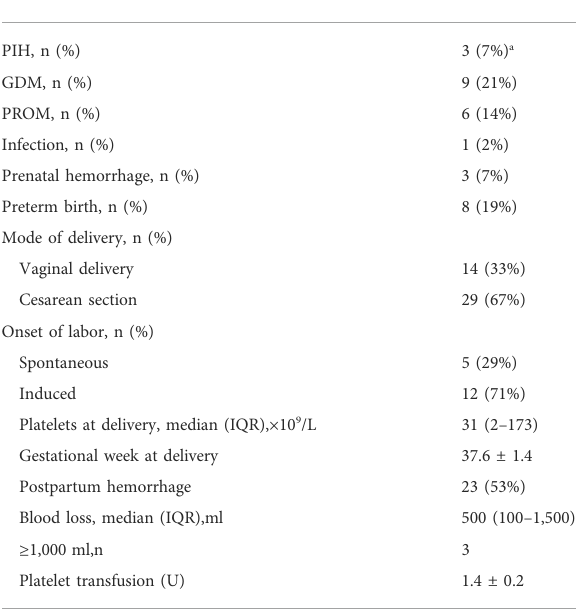
TABLE 3 Maternal outcome of 43 women with low-dose prednisone.